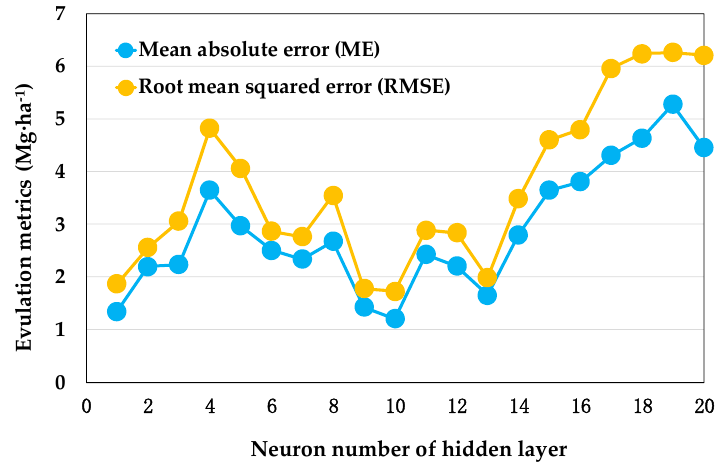
Figure 4. Training errors associated with a given number of neurons in the hidden layer.